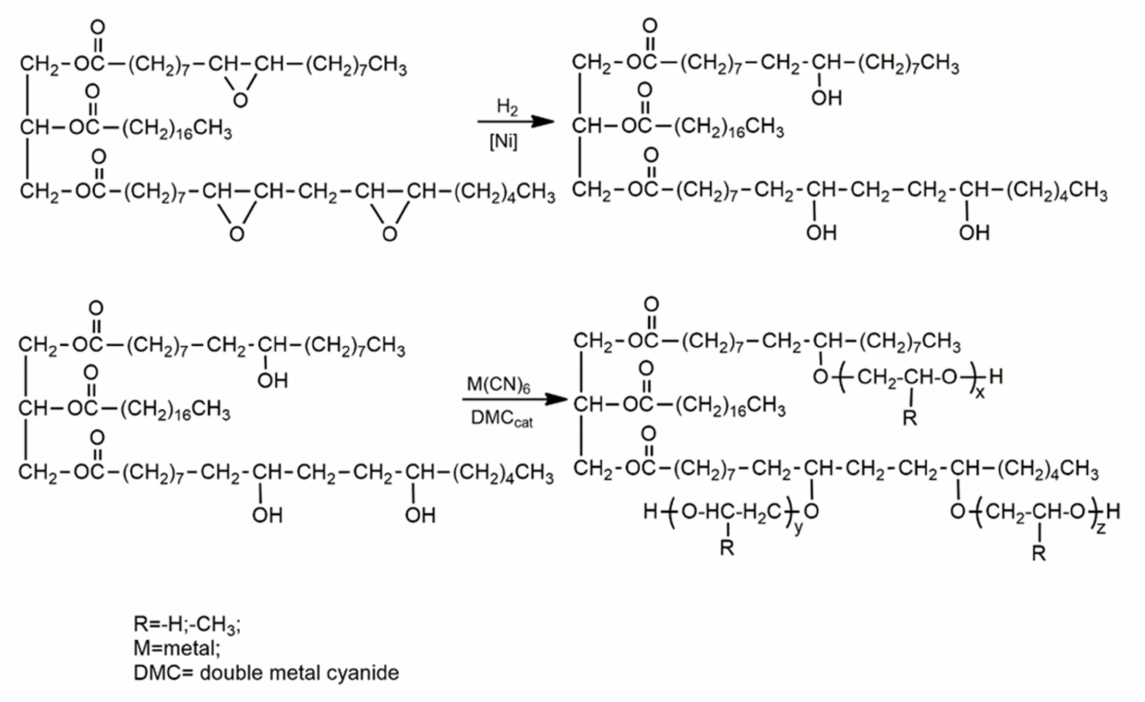
Figure 6. Introduction of primary –OH groups by alkoxylation of the originally –OH substituted secondary